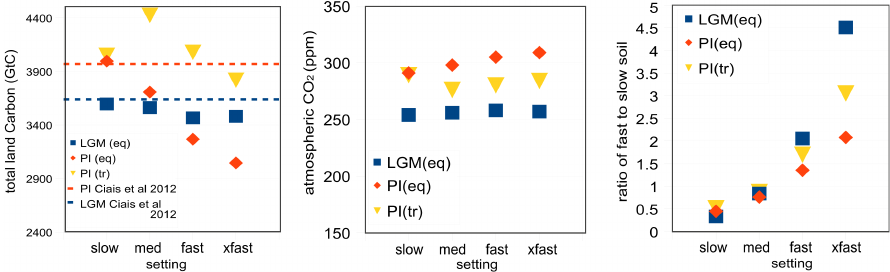
Figure 12. Chosen dynamic settings for the range of permafrost-carbon dynamics. Left: total land carbon with Ciais et al. (2012) estimates as dashed lines. Middle: atmospheric CO 2 (ppm). Right: ratio of all fast to all slow soil pools, indicating the speed of response of the soil carbon to changing climate.